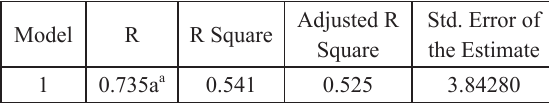
Model Summary for Resistance, Complexity, Relative Advantage, Model